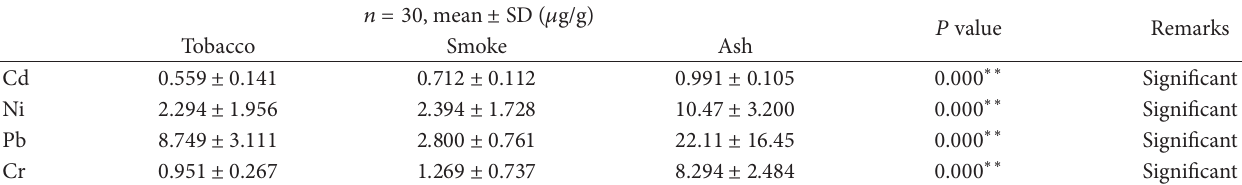
Table 5: Analysis of variance (ANOVA) for imported cigarette brands in tobacco, smoke, and ash. 𝑛 = 30 , mean ± SD ( 𝜇 g/g)